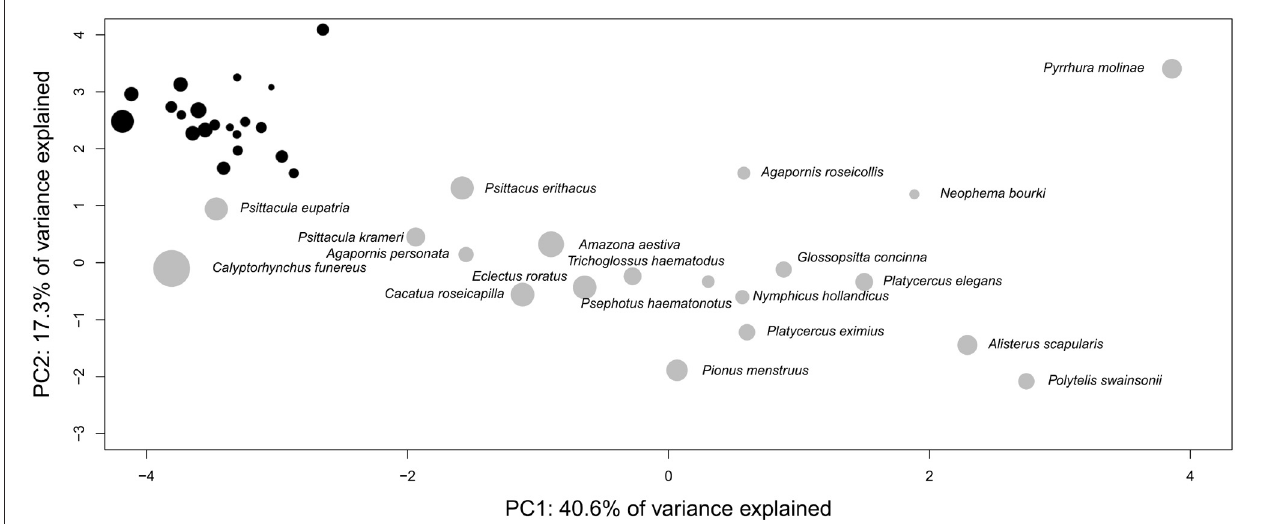
FIGURE 2 | Three dimensions principal component analysis of the proportional size of Psittaciformes brain structures [data from Iwaniuk and Hurd (2005), the analysis includes the size of nidopallium, Wulst, mesopallium, striatopallidal complex, remainder of the telencephalon, optic tectum, cerebellum, diencephalon, and brainstem]. The diameter of the discs indicates the relative size of the brains in the taxon, i.e., the species with the biggest brain in the taxon possesses the largest disc, and the area of the disc of all the other species is proportional to the volume of their brains